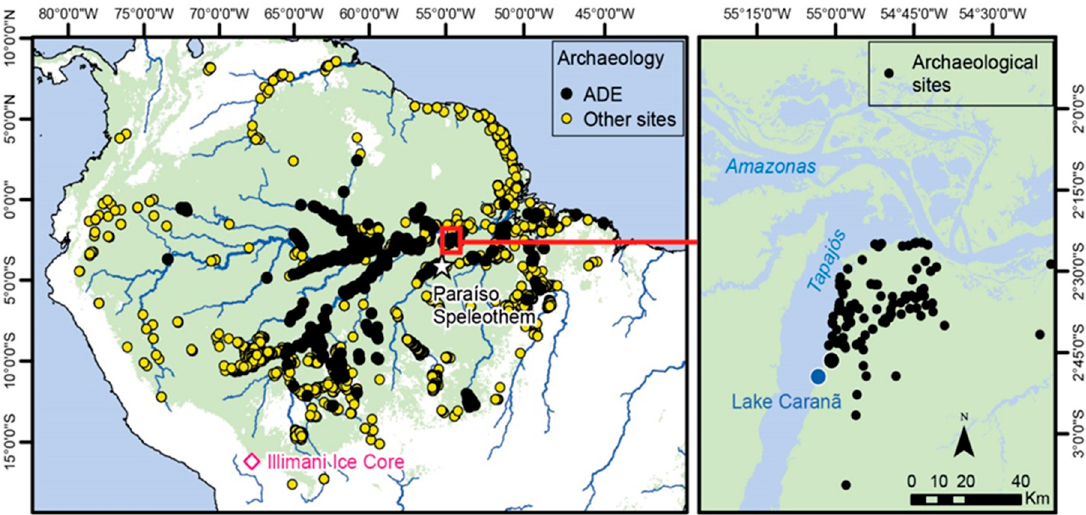
Figure 1. Regional study map. ( Left ) Distribution of archaeological sites including Amazonia dark earths (ADE) used to calculate the Sum of the Calibrated Probability Distributions (SPD) and site frequency values [41,42]. Star indicates Paraíso speleothem record [54]; pink diamond represents Illimani ice core record [12]; red box indicates inset. ( Right ) Study area including Lake Caranã (blue dot). Modified from Maezumi et al. [41,42].